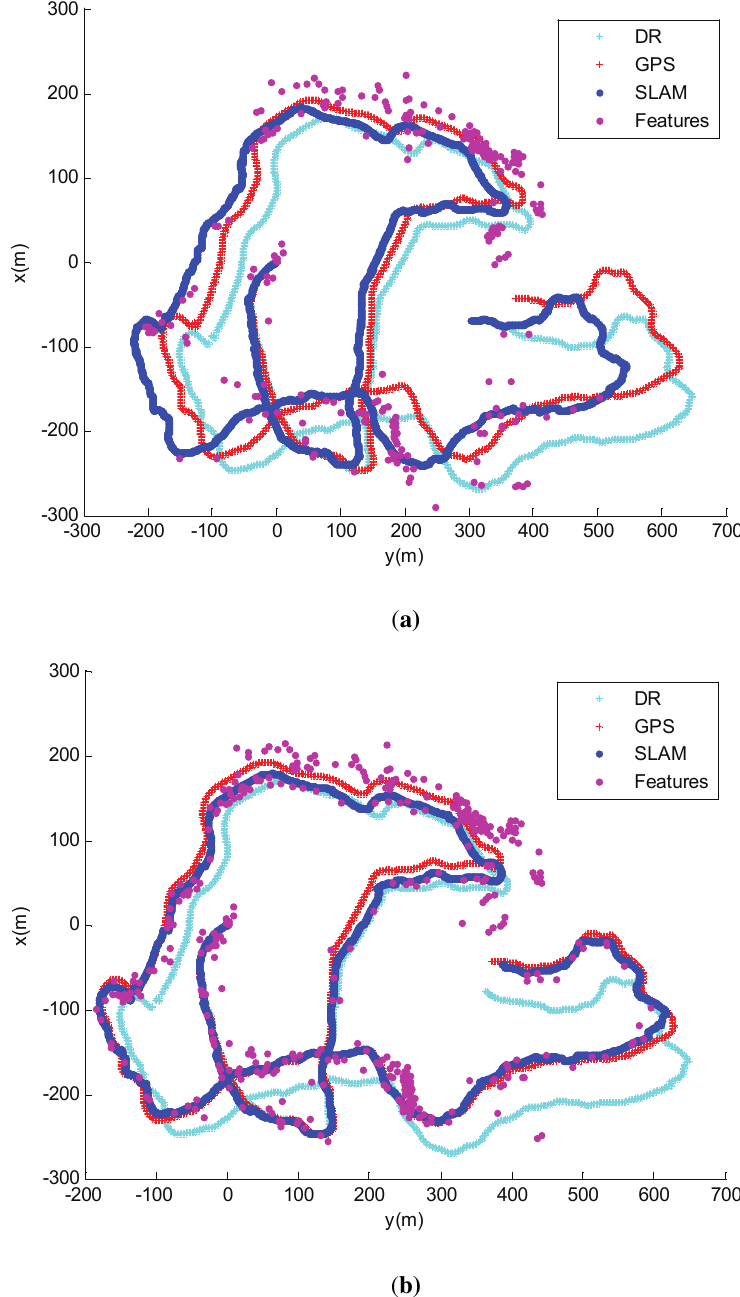
Figure 14. Comparisons of the results estimated by SEIF ( a ) and ISEIF ( b ) in the experiments of the sea